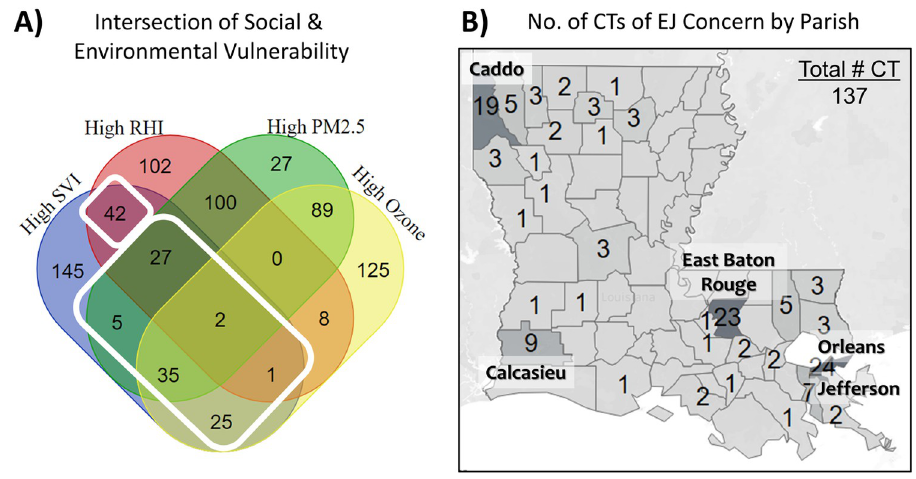
Fig 3. Identifying census tracts with EJ concerns. Census Tracts were defined as being of EJ concern if the Overall SVI was at or above the 75 th percentile, along with at least one of the environmental variables (RHI, PM 2.5 or Ozone) at or above the 75 th percentile for the state (A). Map shows the number of the CTs of EJ concern by Parish (B). Most of them were located in the major urban areas, with a few spread across the rural areas of the